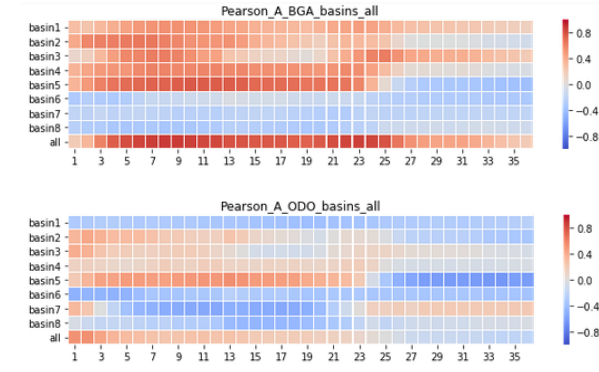
Figure 5. Parameter profiles for the low- and high-classes of the parameters BGA and ODO